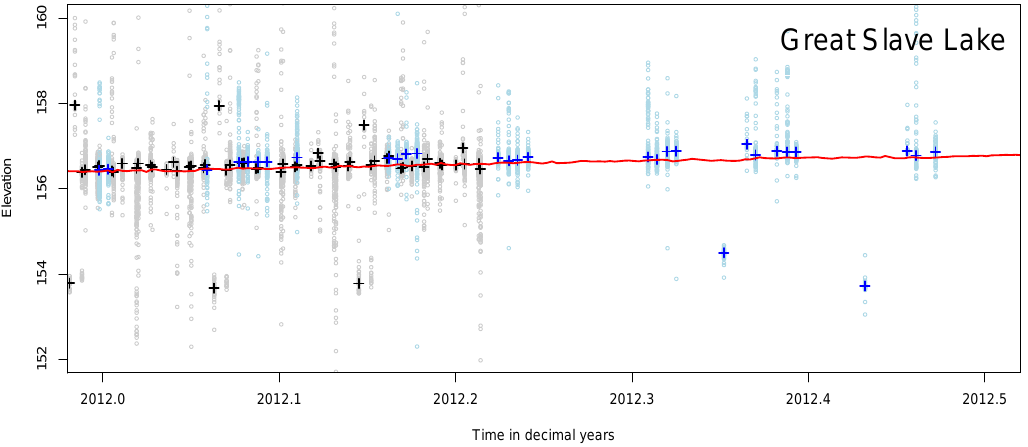
Figure 8. The water level time series of Great Slave Lake between January 2012 and May 2012. The gray (Envisat) and blue (CryoSat-2) circles represent the raw retracked water levels. The black (Envisat) and blue (CryoSat-2) crosses represent the predicted water level, and the red line is the in situ water